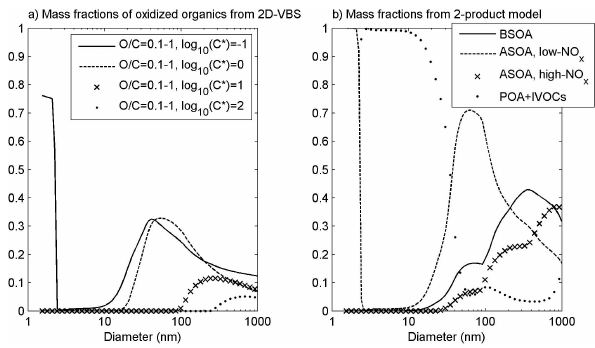
Fig. 12. (a) Size resolved organic mass fractions of oxidized com- pounds (O:C-ratio between 0.1 and 1) with different saturation con- centrations (C ∗ ). The results are from the base case simulation with the 2D-VBS model, 24h downwind of Malm¨o. (b) Size resolved mass fractions of BSOA, ASOA from BTX oxidation through the low- and high-NO x pathway, and POA and IVOC oxidation prod- ucts. The results in (b) are from the two-product model simulation, 24h downwind of